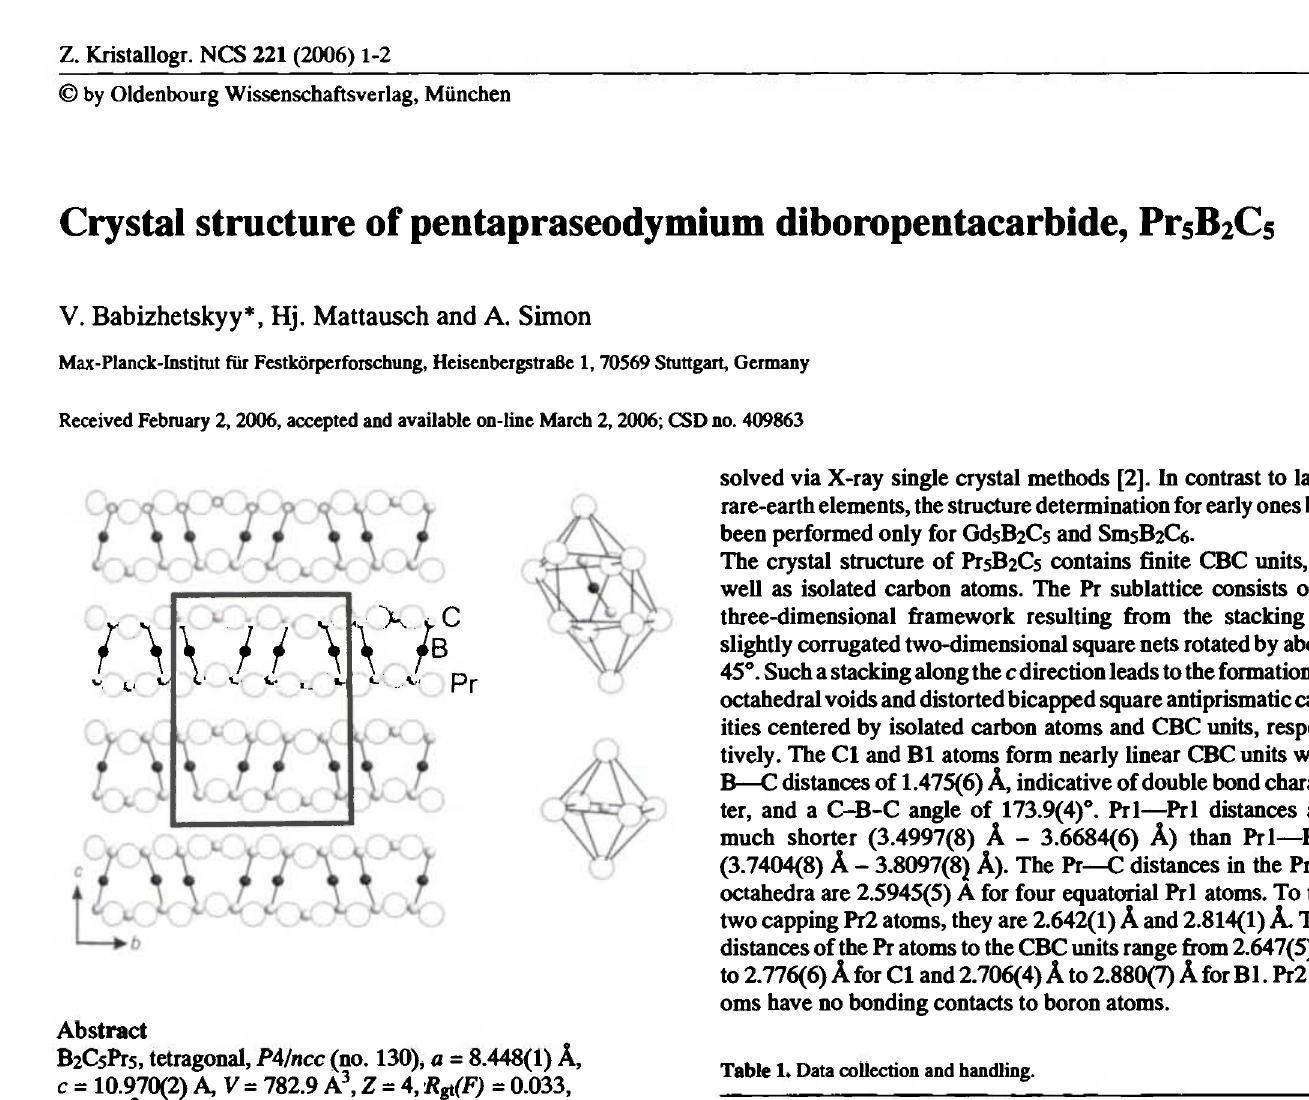
Table 1. Data collection and handling.